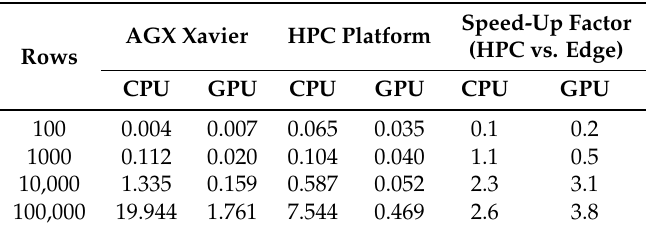
Table 3. Comparison of the execution time (in seconds) of the GPU and CPU implementations of the FCM algorithm between the HPC and edge computing platforms.